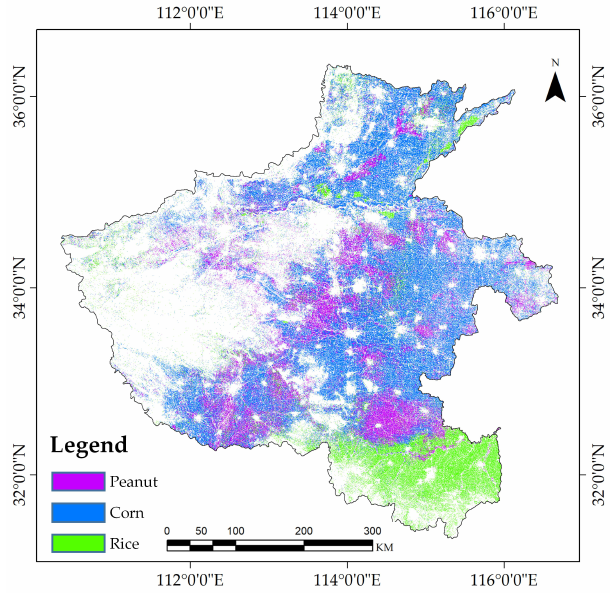
Figure 12. Mapping results of corn, peanut, and rice from Sentinel-2 images in Henan Province, China, obtained by the proposed SPTNet